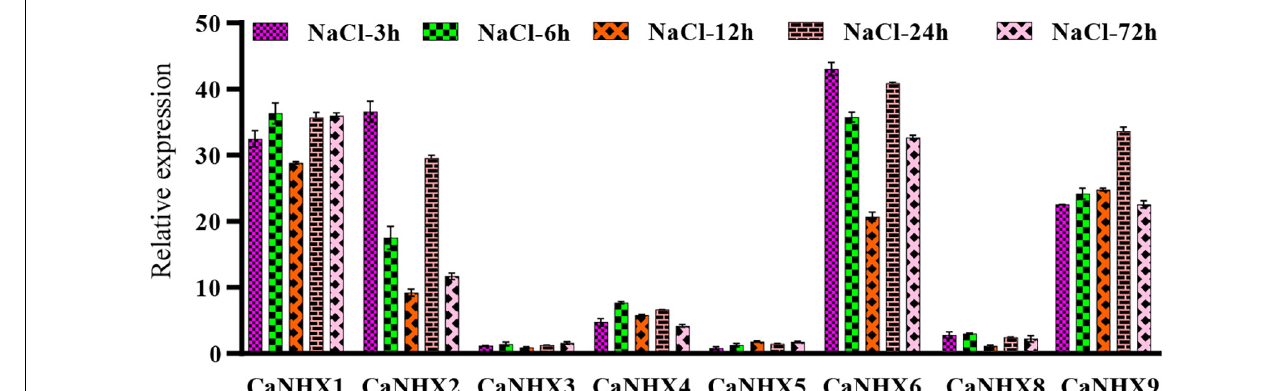
FIGURE 9 | Quantitative RT-PCR analysis of pepper CaNHX